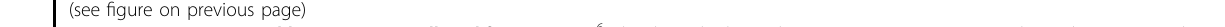
Fig. 2 METTL3 promoted breast cancer cell proliferation. A M 6 A level was higher in breast cancer tissues (tumor) than adjacent normal tissues (normal) ( n = 32). B The mRNA expression of METTL3 was higher in breast cancer tissues (tumor) than adjacent normal tissues (normal) ( n = 90), *** p < 0.001. The relative RNA level was calculated by the 2 − ΔΔ Ct method and normalized based on β -actin. The average mRNA level of adjacent normal tissues was set as 1. C Kaplan – Meier survival curves of disease-free survival (DFS) in 90 breast cancer patients based on METTL3 expression showed that higher expression of METTL3 tended to be correlated with shorter DFS of breast cancer patients. The log-rank test was used to compare the difference between the two groups ( p = 0.062). D – F Knockdown of METTL3 signi fi cantly decreased the growth of SUM-1315, MCF-7, and BT-474 cells by CCK-8 assay. * p < 0.05, ** p < 0.01, *** p < 0.01 vs. scrambled control group (shNC). G , H Knockdown of METTL3 decreased the colony formation ef fi ciency in SUM-1315 and MCF-7 cells. *** p < 0.001 vs. scrambled control group (shNC). I , J Cell cycle analyzed by fl ow cytometry.